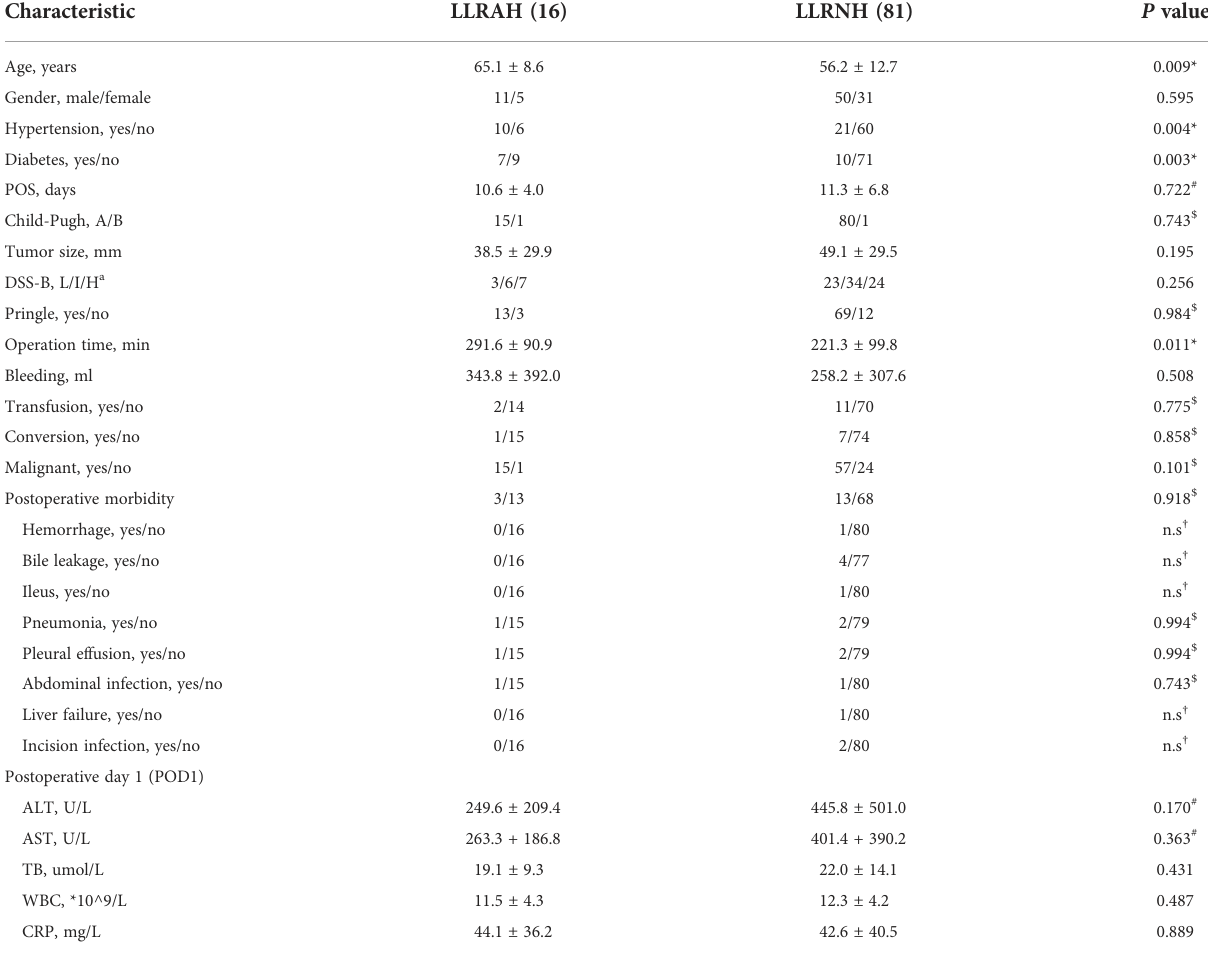
TABLE 1 Patient characteristics and surgical outcomes of LLR between LLRAH and LLRNH.